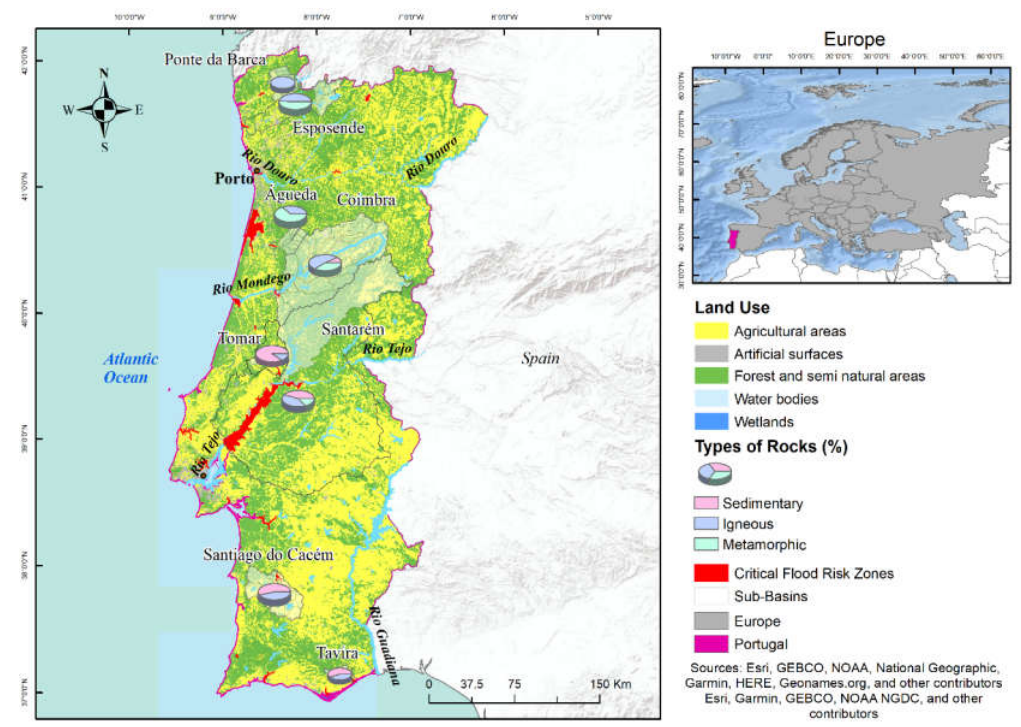
Figure 1. Spatial distribution of flood risk critical zones of continental Portugal.